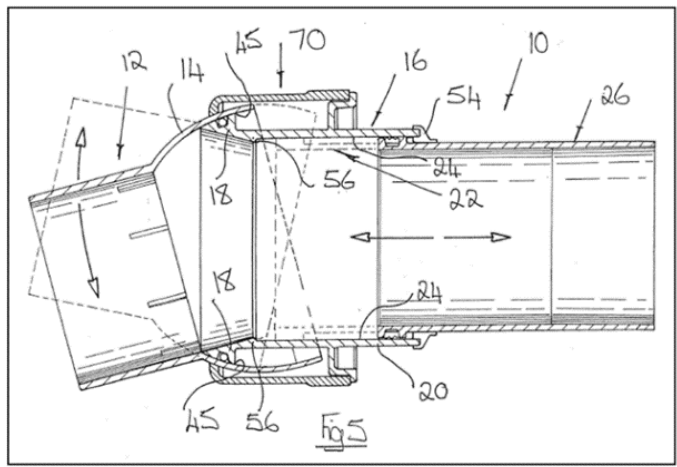
Figure A1. Scheme of the joint for pipelines, patent AU2011101376A4. Pipeline Turning Joint (CN102588689A)